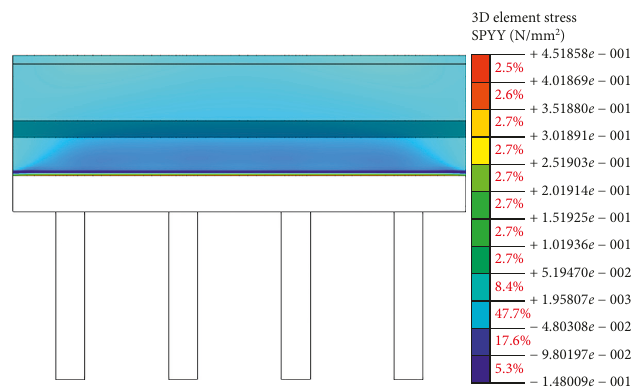
Figure 11: Lateral stress distribution in the abutment under Condition 1